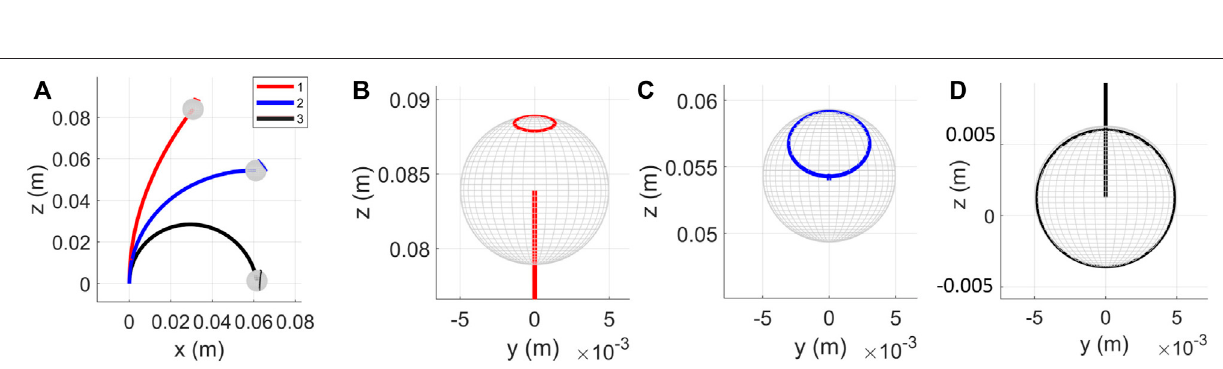
Figure 11 for the corresponding three con fi gurations displayed in Figure 10B . We see that the variation in length is in the millimeter range, which aligns with the observations made in the preliminary study. It is interesting to note that